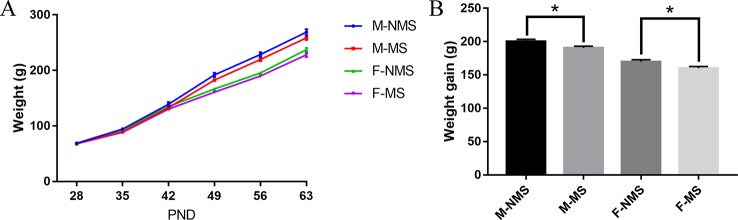
MS reduces the body weight of SD rats. (A) The tendency of weight gain from PND28 to PND63. (B) Weight gain from PND28 to PND63 after MS. Statistical analyses are performed by two-way ANOVA followed by t-test. Values are presented as mean ± SEM, *p < 0.05. n = 15 per group.